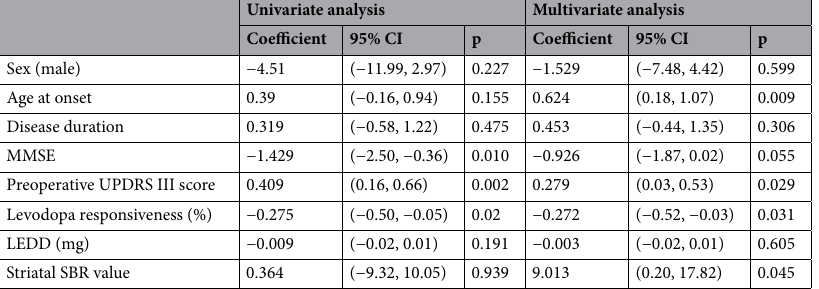
Table 3. Univariable and multivariate regression analysis of the factors associated with the UPDRS III scores in the medication on stimulation on state 12 months after GPi DBS in patients with advanced Parkinson’ disease. DBS, deep brain stimulation; GPi, globus pallidus interna; MMSE, Mini-Mental State Examination; SBR, specific binding ratio; LEDD, levodopa equivalent daily dose; UPDRS, Unified Parkinson’s Disease Rating Scale.